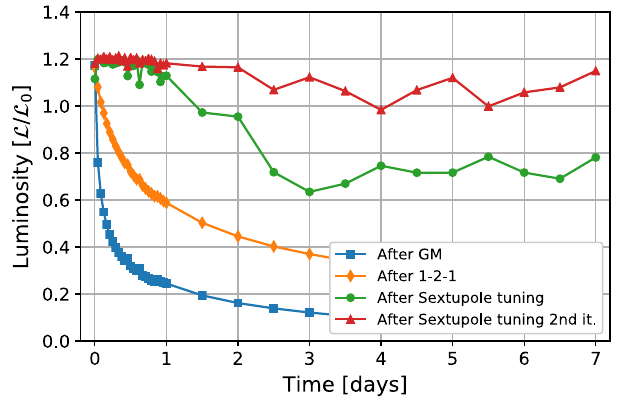
FIG. 12. Luminosity recovery for downtimes up to 7